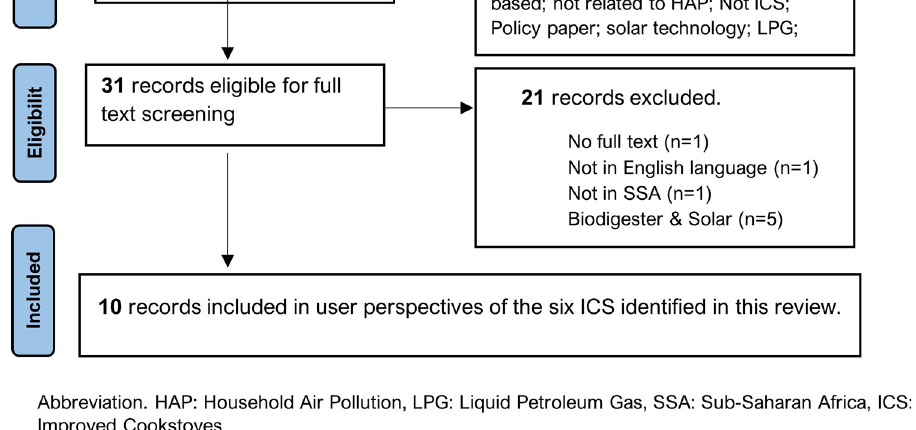
Fig 6. PRISMA flow diagram showing the selection of sources for User